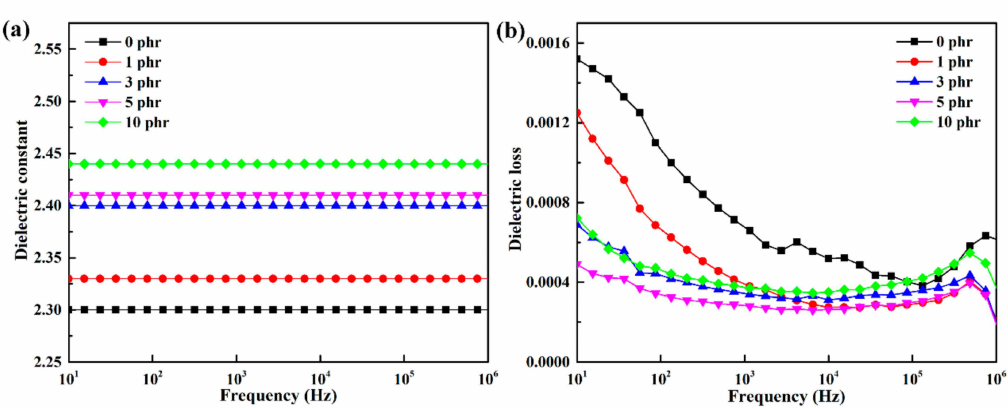
Figure5. Relationshipbetween( a )dielectricconstantand( b )dielectriclossandfrequencyofh-BN / LDPE composites with di ff erent